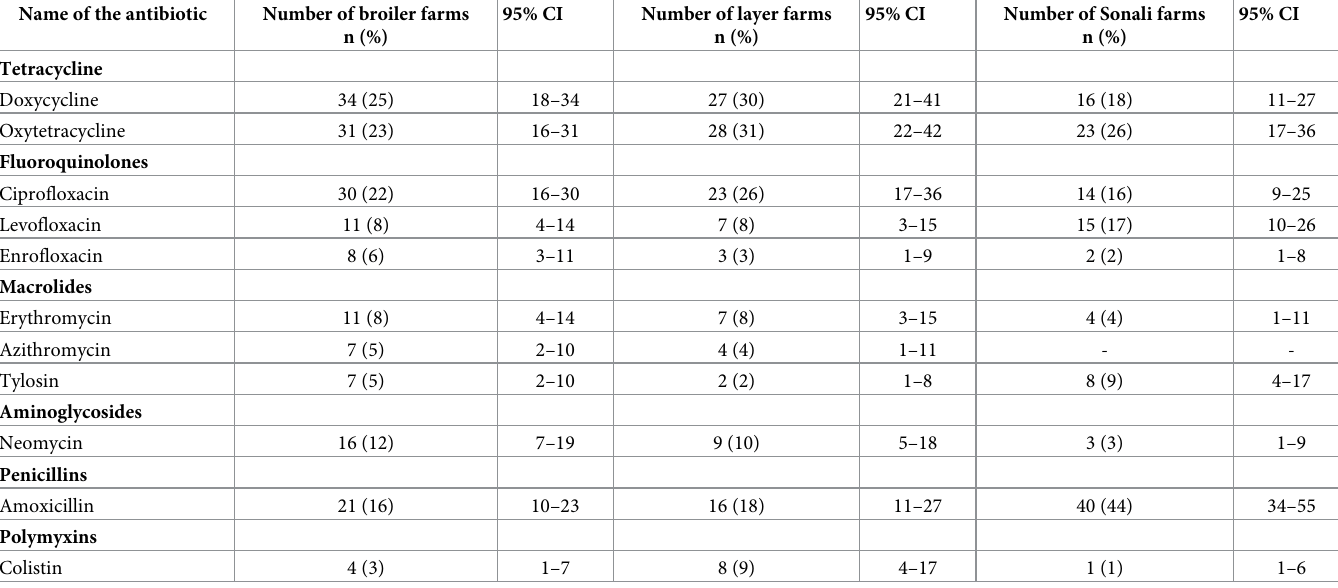
Table 3. Types of antibiotics used within the24 hours preceding visits to broiler (N = 134), layer (N = 90) and Sonali (N = 90) farms in Bangladesh during January- May